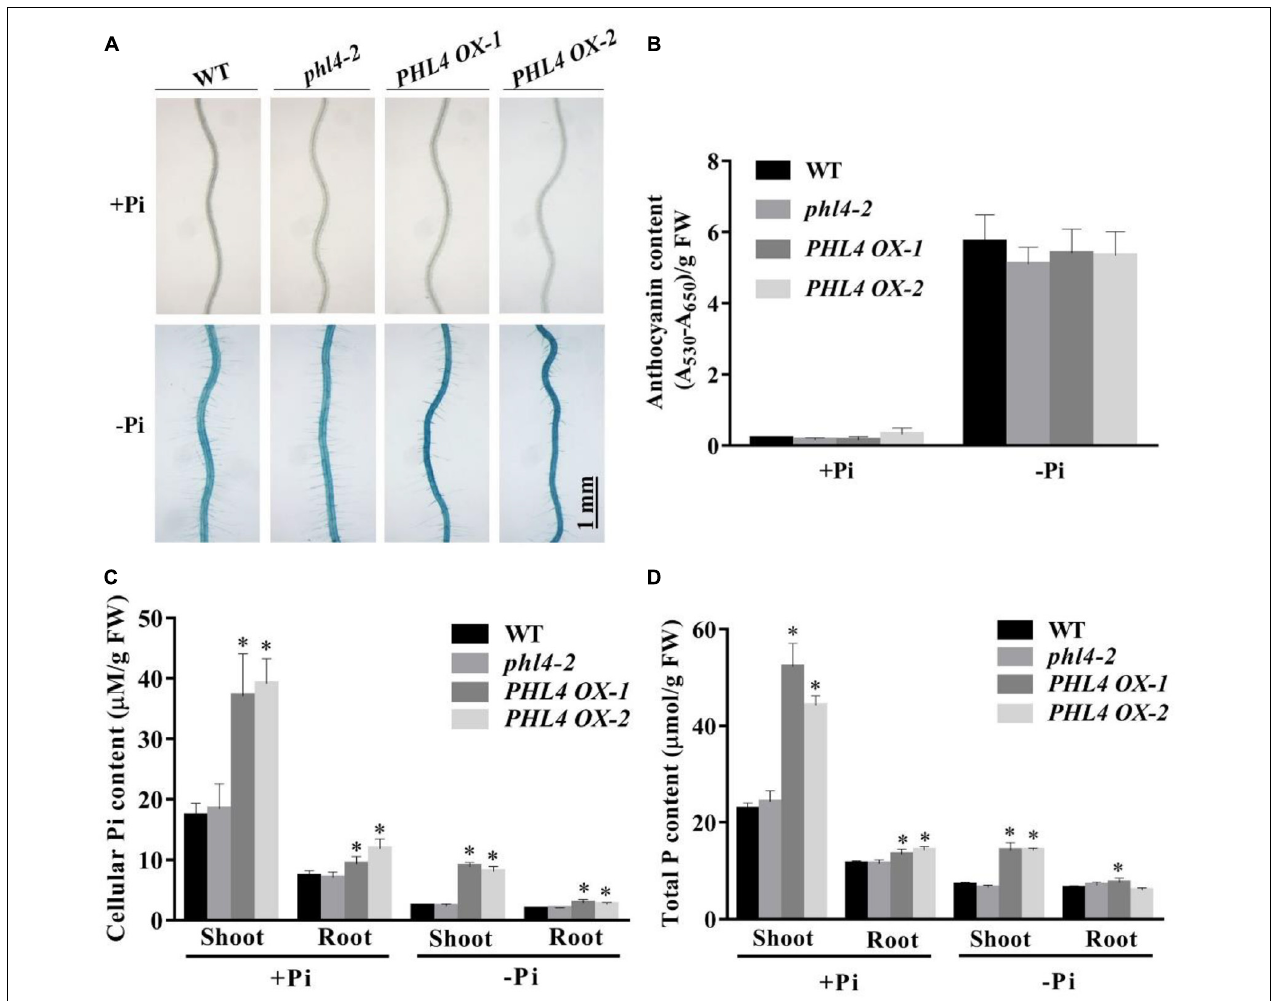
FIGURE 10 | Analyses of root-associated APase activity, anthocyanin, cellular Pi, and total P contents of the two PHL4 -overexpressing lines ( PHL4 OX-1 and PHL4 OX-2 ) grown on +Pi and –Pi media. (A) The APase activities revealed by BCIP staining on the root surfaces of 6-day-old seedlings of the WT, phl4 , and PHL4 OX-1 and -2 . (B) Anthocyanins in the shoots of 12-day-old seedlings of the WT, phl4 , and PHL4 OX-1 and -2 . (C,D) Cellular Pi and total P contents in the shoots and roots of 12-day-old seedlings of WT, phl4 , and PHL4 OX-1 and -2 . These experiments were repeated three times with similar results. Values represent means ± SD of three replicates. Means with asterisks are significantly different from the WT ( P < 0.05, t